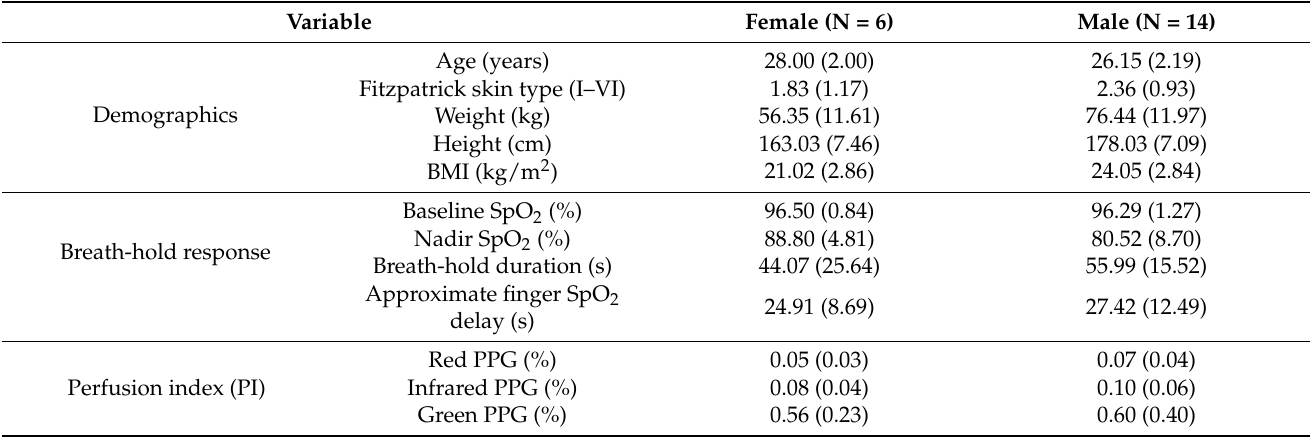
Table 1. Demographics and physiological responses during breath-hold of the subjects included in the